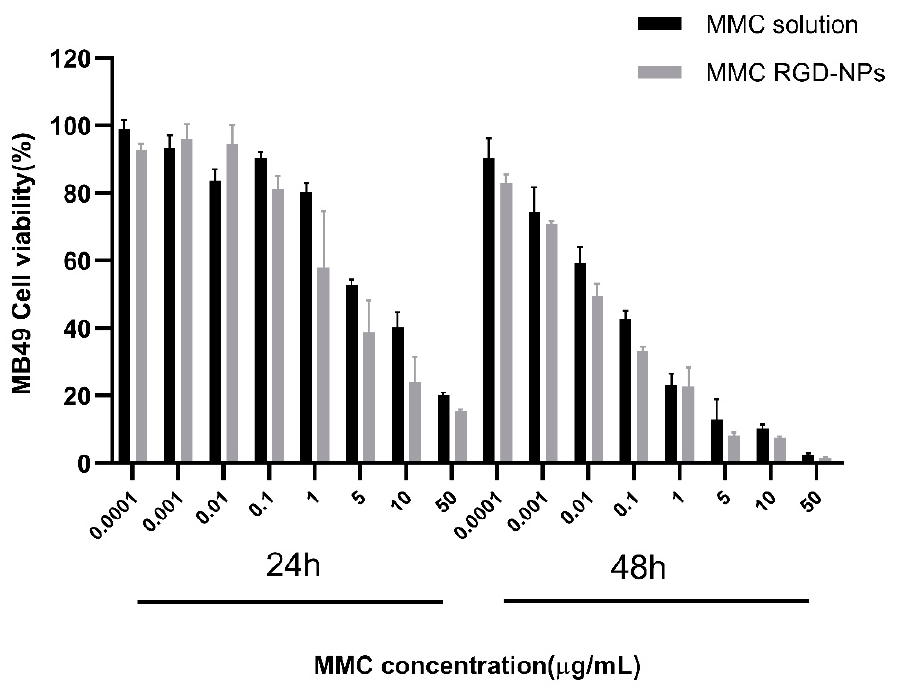
Figure 9. The cell viability of MB49 cells compared to the MMC solution and MMC RGD-NPs for 24 or 48 h.